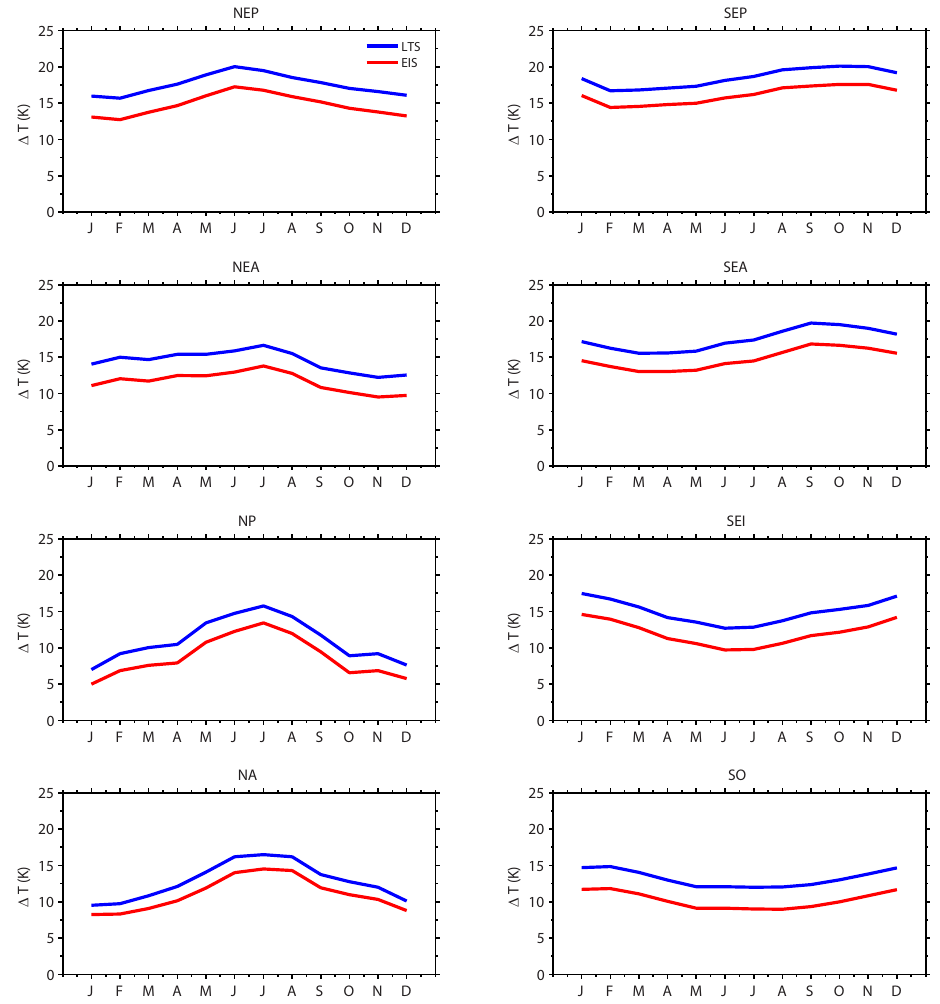
Figure 4. Same as Fig. 3 but for lower tropospheric stability (LTS, blue) and estimated inversion strength (EIS, red). Statistics are based on 5 years of data from the ECMWF-AUX CloudSat product.